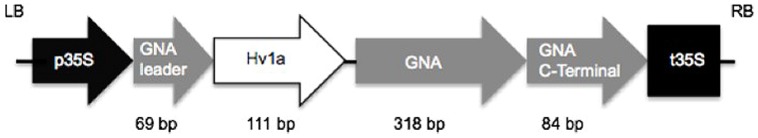
Structure of plant constructs in pK2GW7 vector.